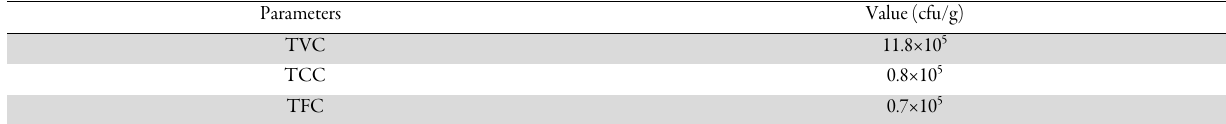
Table 5. Microbial properties of the poultry droppings